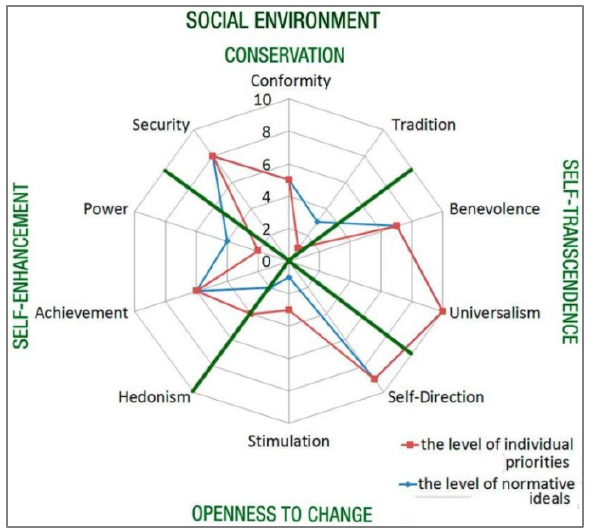
Fig. 10. Schwartz's circle of values for a sample of graduate